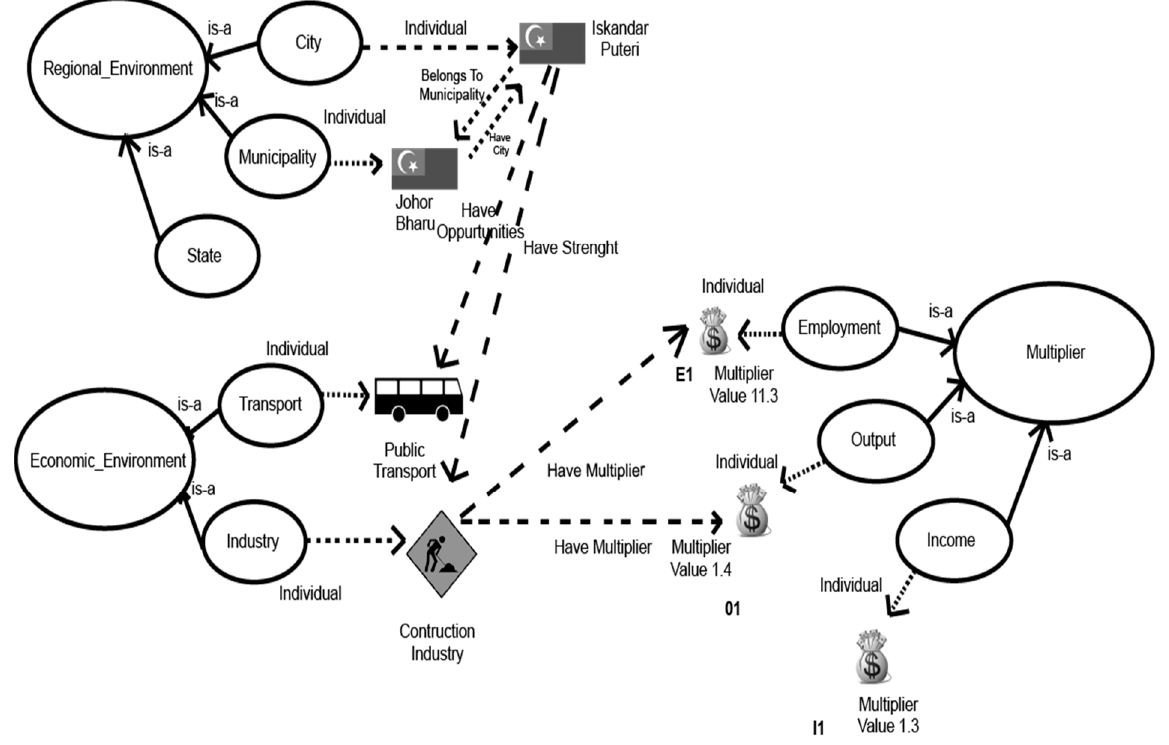
Figure 7. Populated